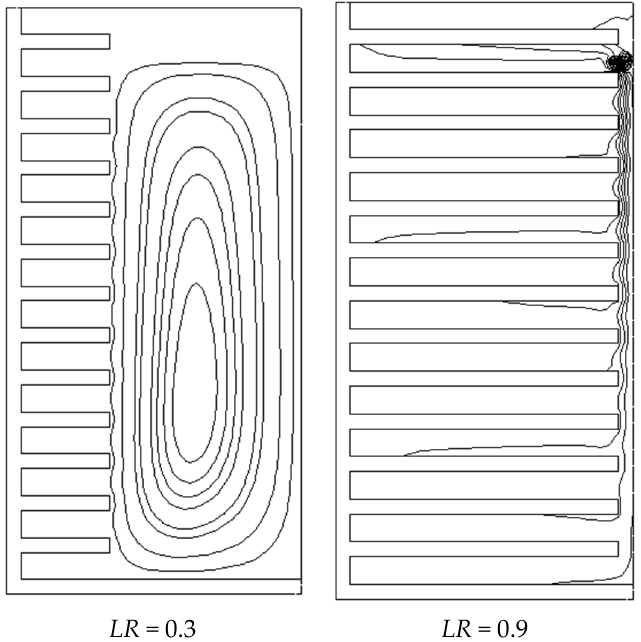
Figure 9. Comparison of strength convection between LR = 0.3 and LR = 0.9 ( n = 13, H = 10 mm).